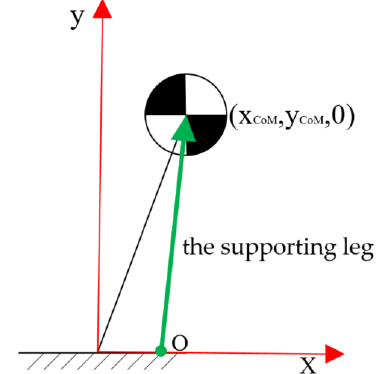
Figure 6. The inverted pendulum model.